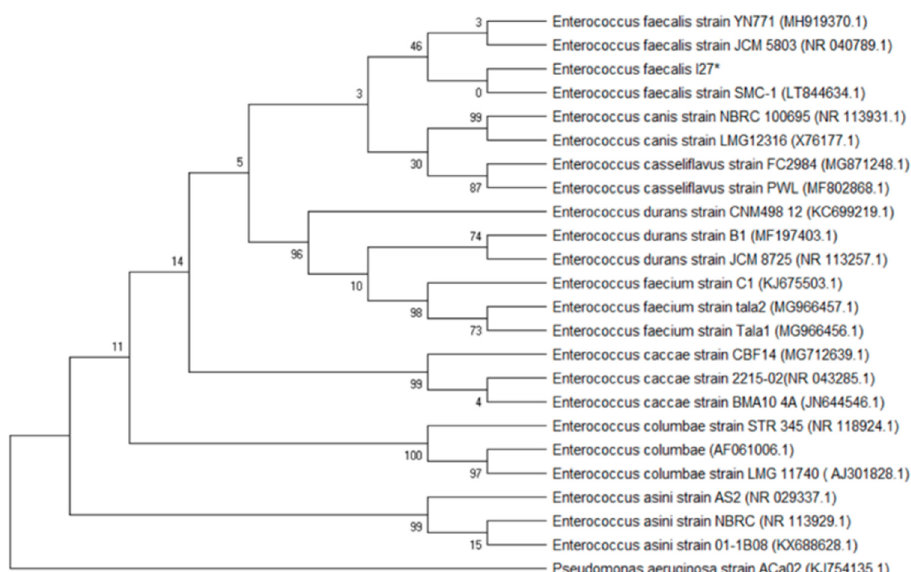
Figure 4. Phylogenetic tree based on the 16 S rRNA gene sequences of Enteroccus (I27) and reference sequences. The analysis included 24 sequences selected from GenBank, and the access number is given in parenthesis. An asterisk identifies the bacterial isolate from this study.